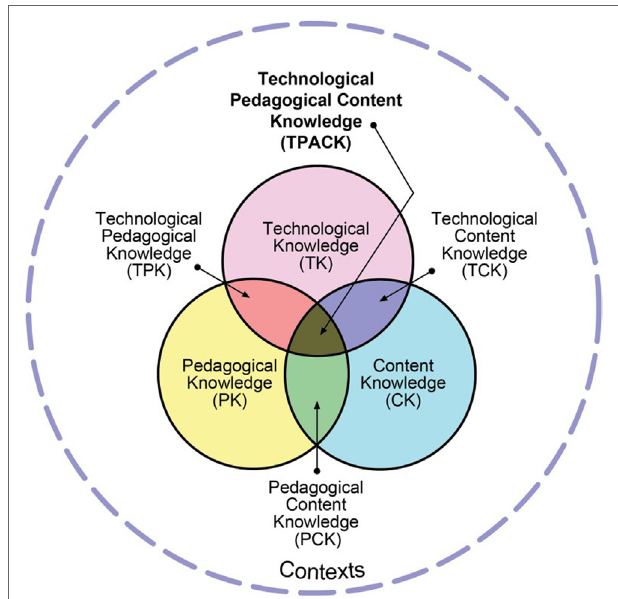
FiGuRe 1 | The Technological Pedagogical Content Knowledge (TPACK) model (Mishra and Koehler, 2006). Reproduced by permission of the publisher, © 2012 by